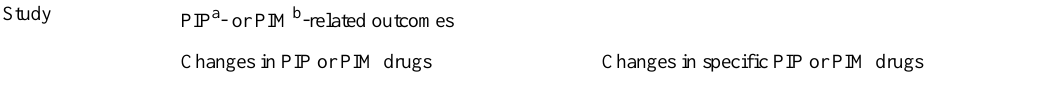
Changes in specific PIP or PIM drugsChanges in PIP or PIM drugs Number of PIP started per 1000 visits: drug-disease contraindication C: